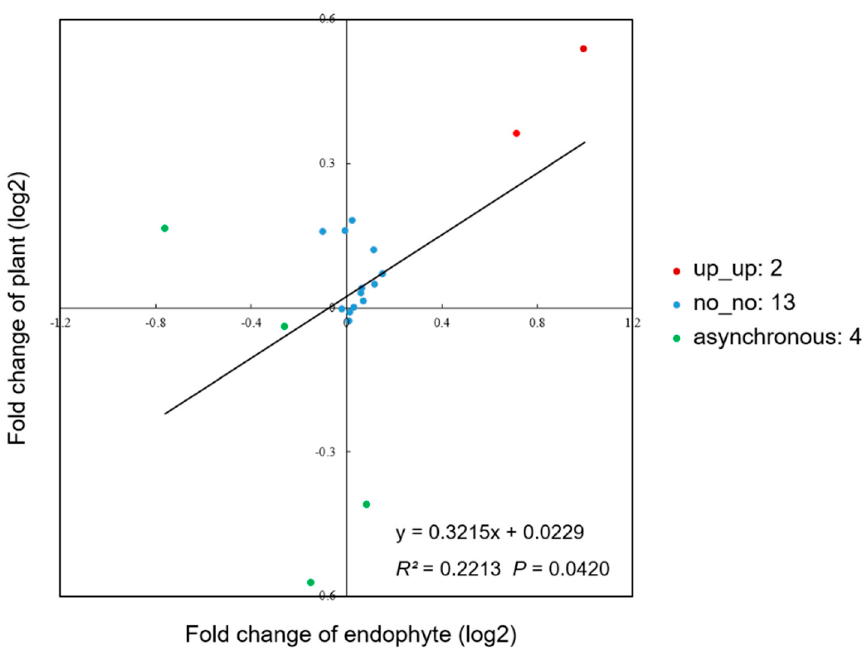
Figure 8. Scatter plot of correlation analysis of metabolites in Epichloë endophyte and A. sibiricum . The fold change of endophyte is the metabolite content ratio of Es to Eg, and the fold change of plant is the metabolite content ratio of Es+ plants to Eg+ plants. “up_up” refers to significant increase in both the endophyte and the plant, “no_no” refers to insignificant change in both endophyte and plant, “asynchronous” refers to asynchronous change between the plant and the